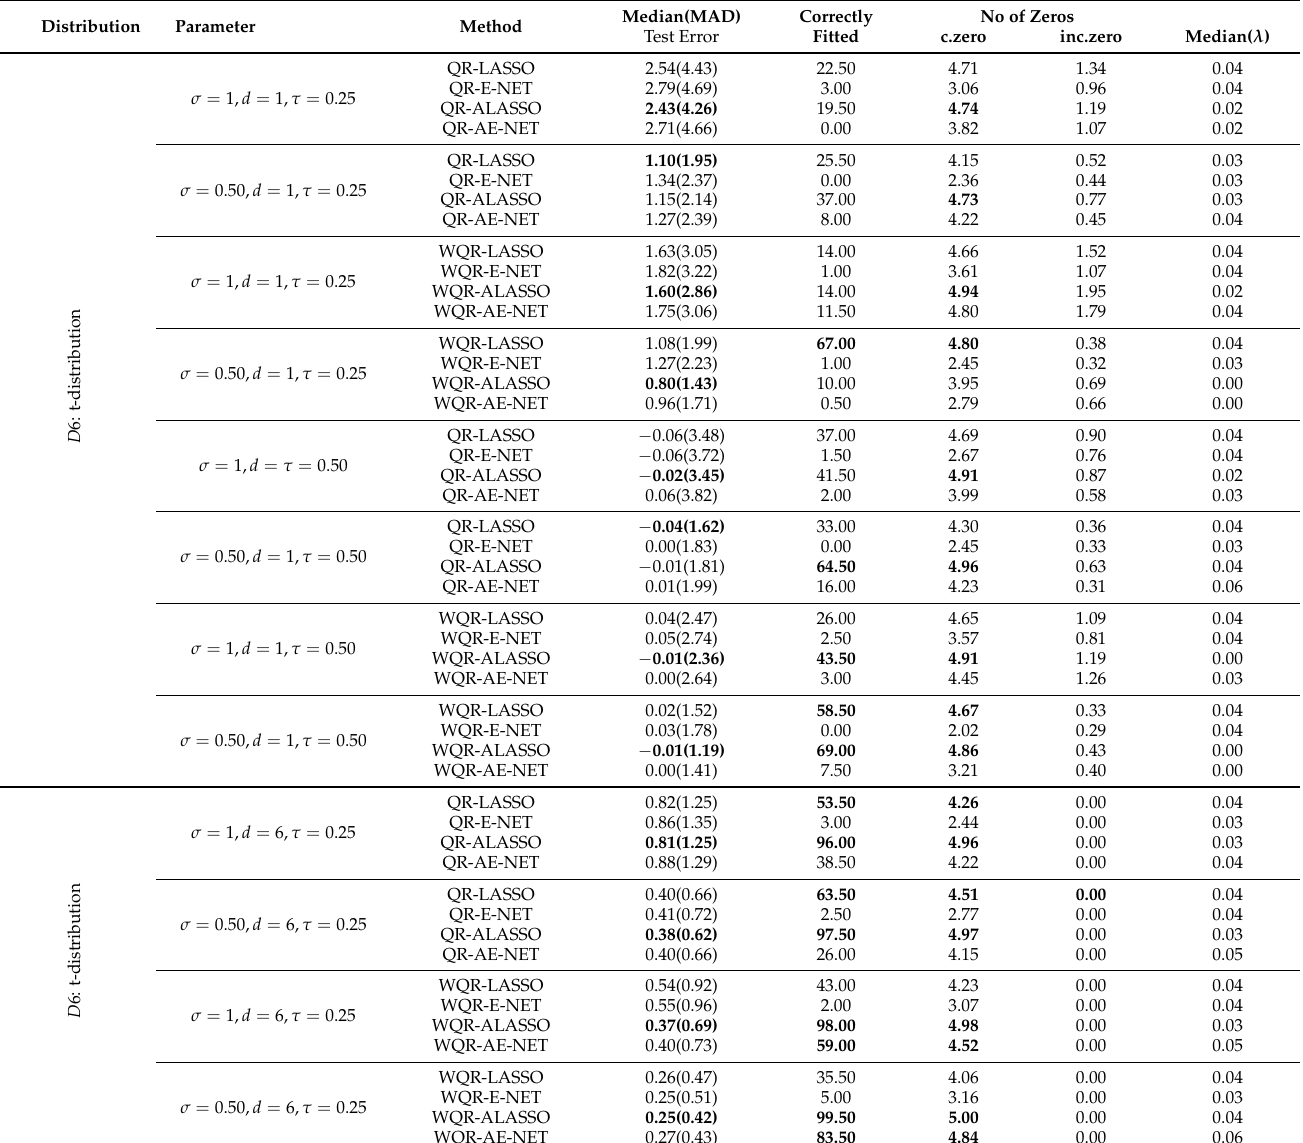
Table 6. Penalized weighted and unweighted quantile regression at D 6 under the heavy-tailed t-distribution for n = 50 ( τ = 0.25 and τ = 0.50); bold text indicate superior